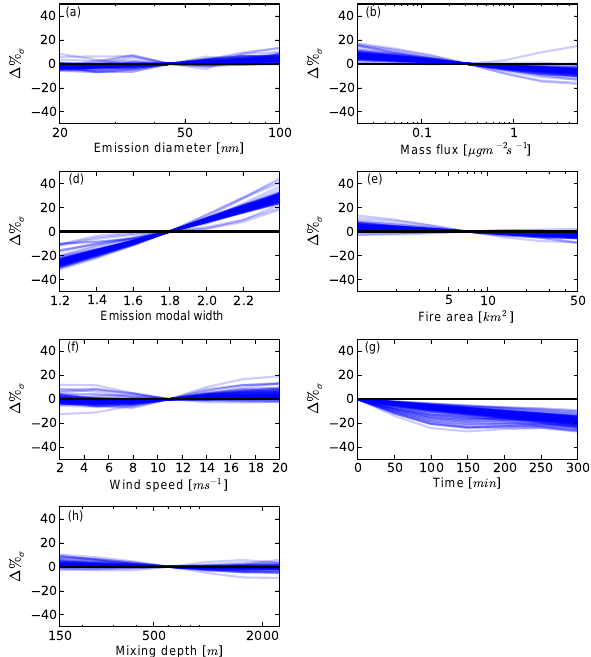
Figure 8. Sensitivity plots for the seven input parameters to the GEM-SA σ emulator parameterization. For each panel, a single in- put parameter is varied systematically from its minimum to maxi- mum value for 100 randomly chosen sets of the other six parame- ters (100 lines in each panel). The sensitivities are shown as percent change in final σ , individually normalized to the center value of the x axis (to zero in